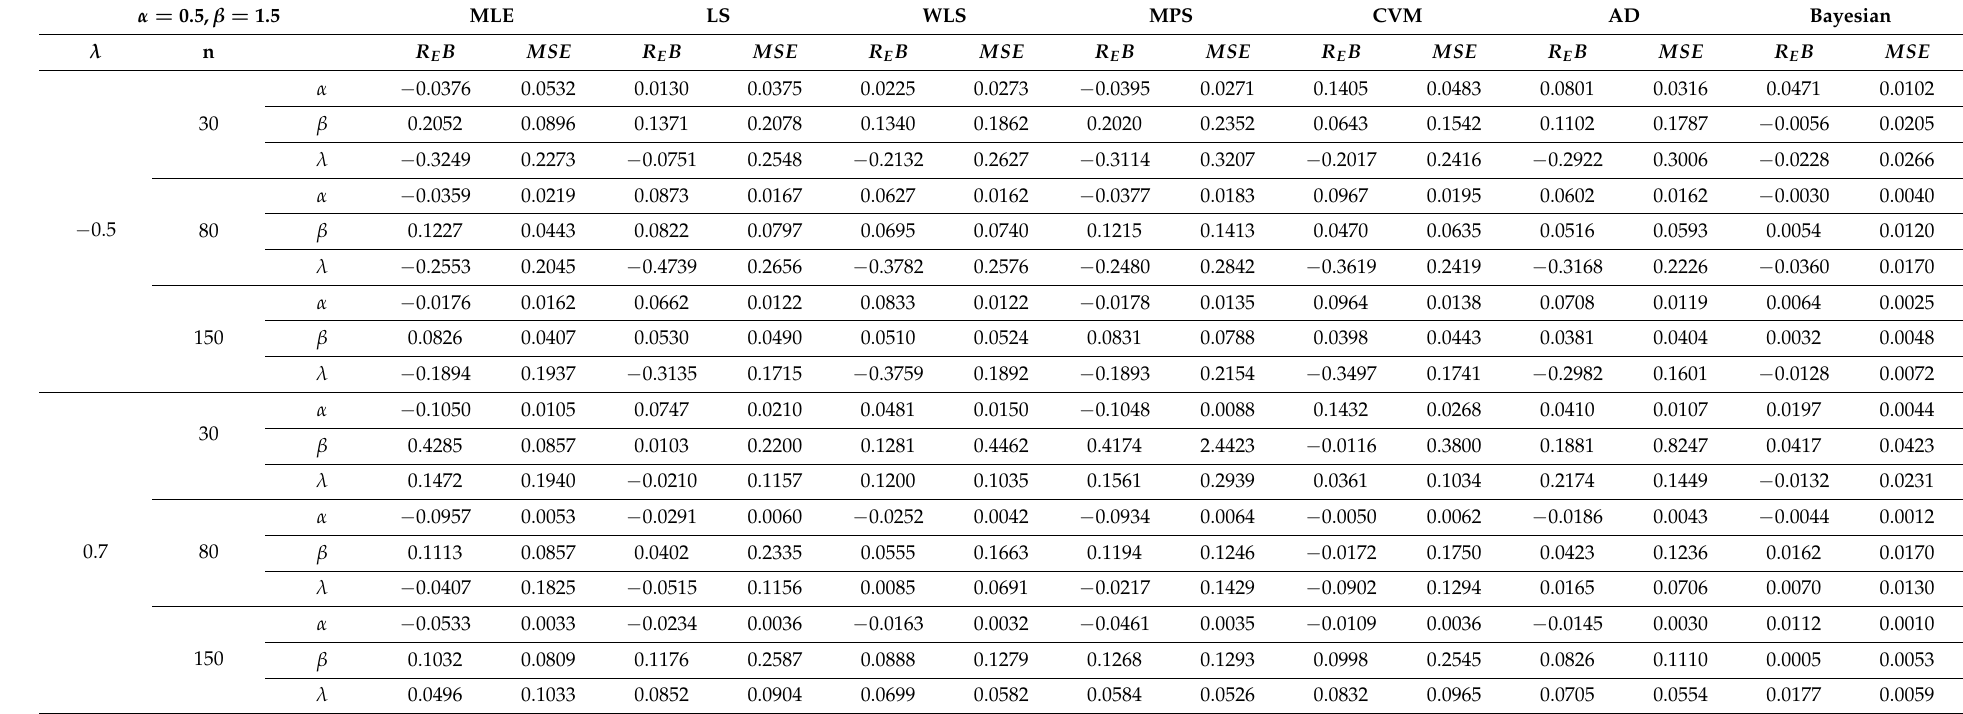
Table 2. Numerical outcomes of R E B and MSE for all estimation approaches at Case